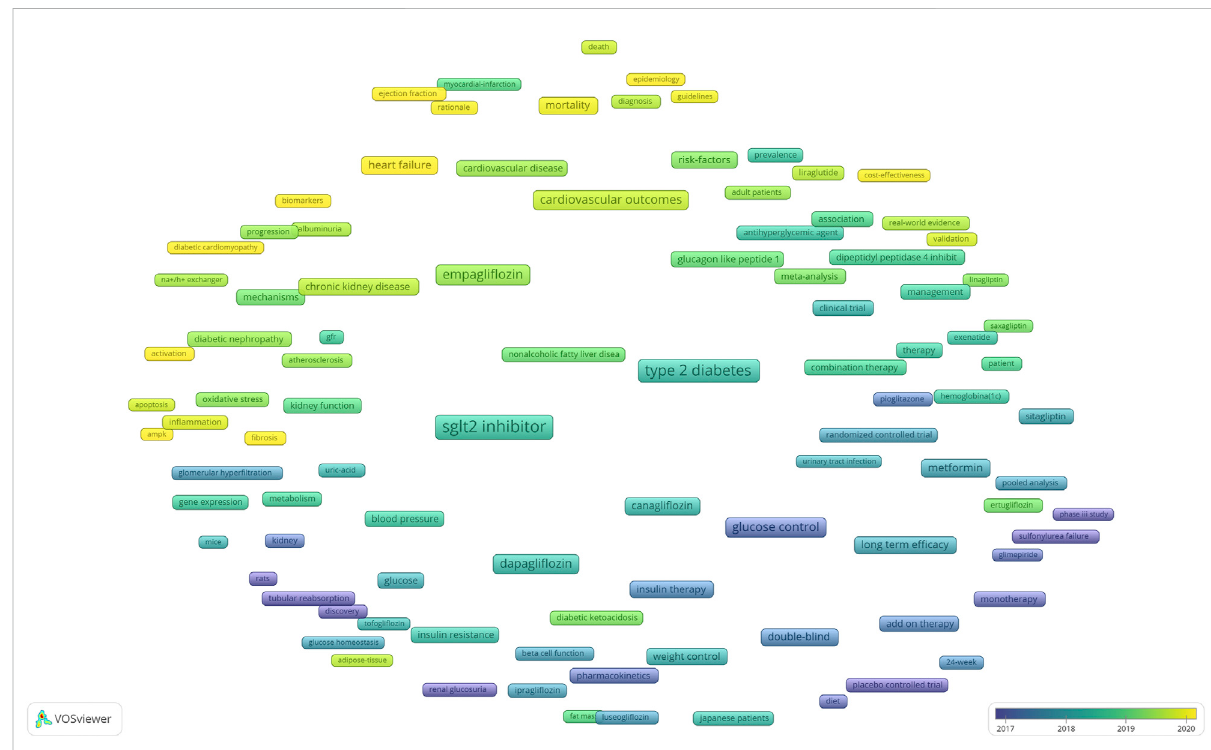
FIGURE 8 Co-occurrence overlay visualization map of the top 100 keywords. The color of the node represents the average publication year of the keywords, and the blue to yellow represents the average publication year from early to